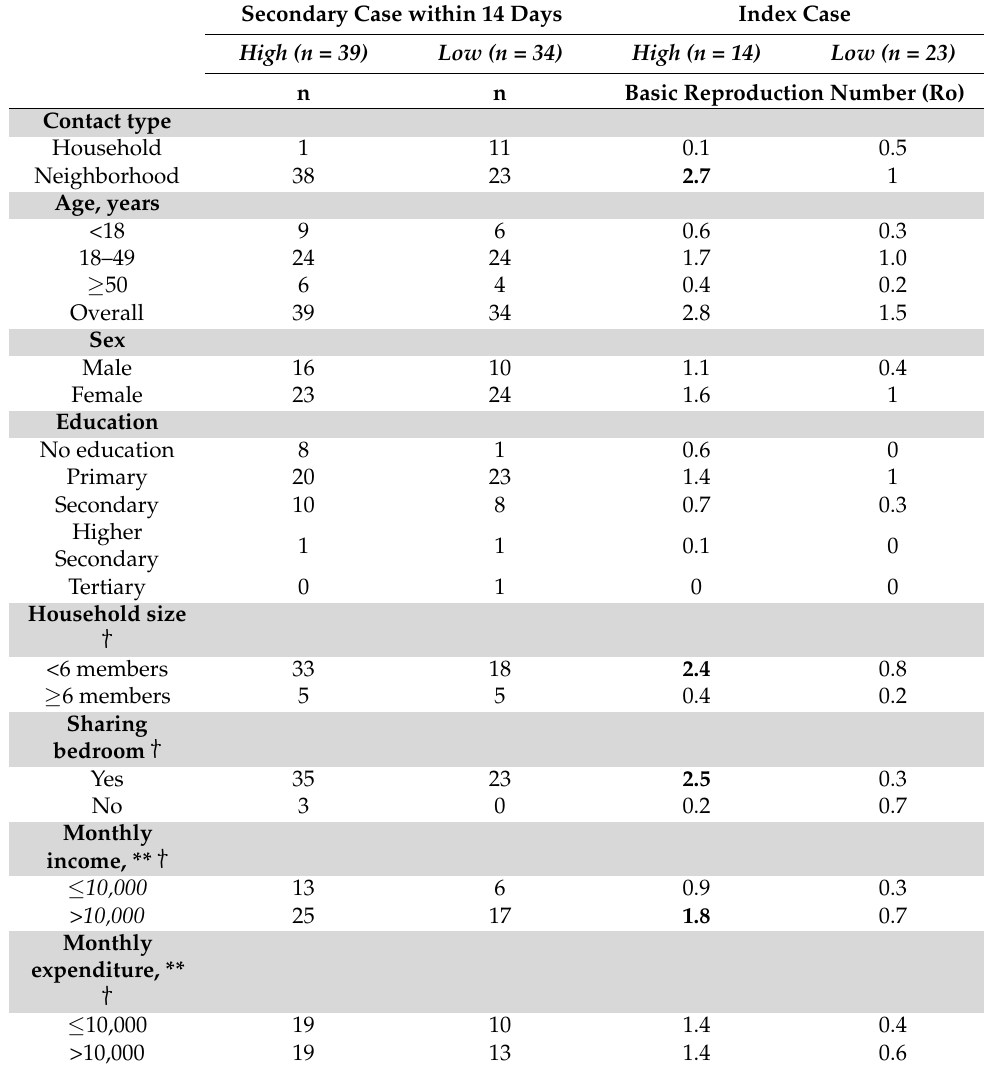
Table 3. Estimation of the basic reproduction number (Ro) in high-density and low-density areas in Table 2. Secondary attack rate (SAR) in high-density and low-density areas in Dhaka city. Dhaka city.